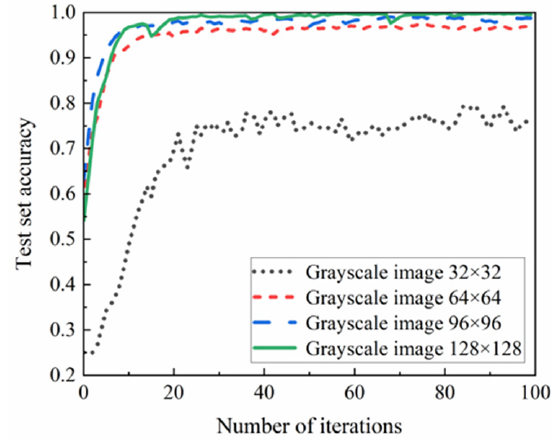
Figure 8. Contrast of different pixel precision.